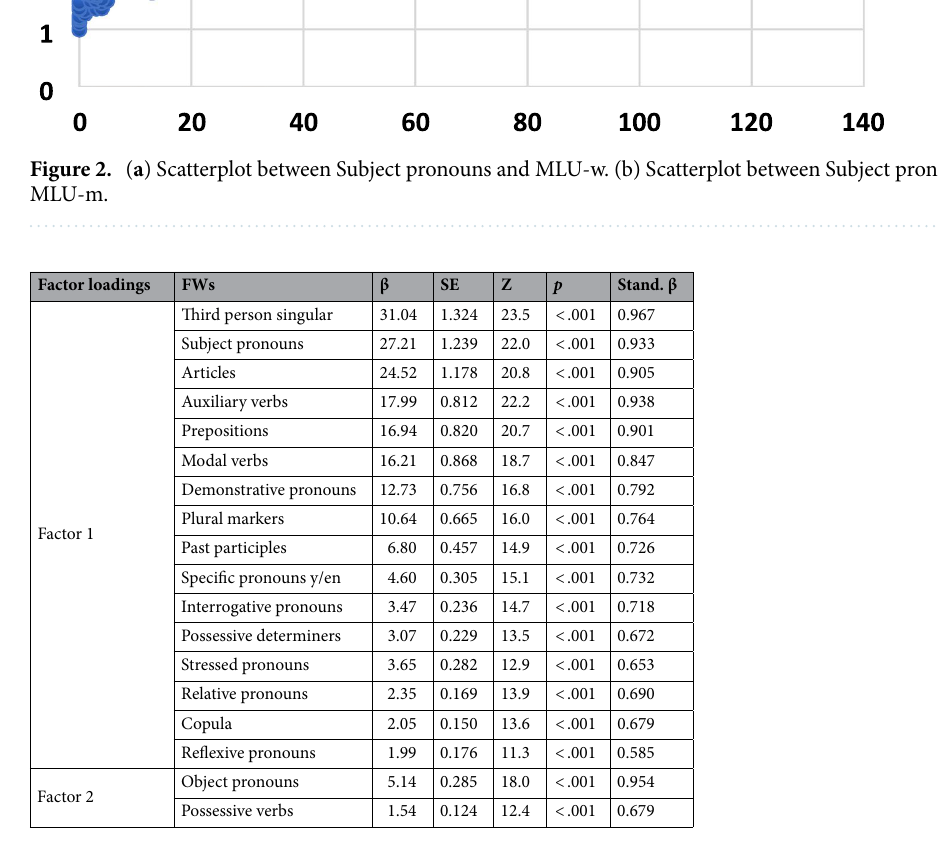
Table 8. Confirmatory factor analysis (CFA) across Function